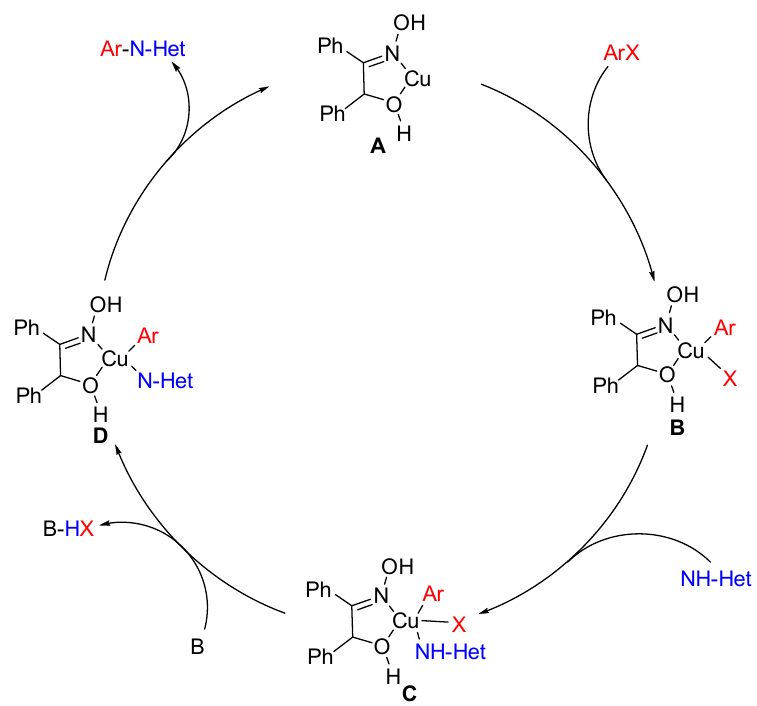
Figure 2. Proposed mechanism for the couplings of (hetero)aryl halides with N -containing heterocycles. NH-Het represented N-hetero nucleophiles; X was bromine or chloride.